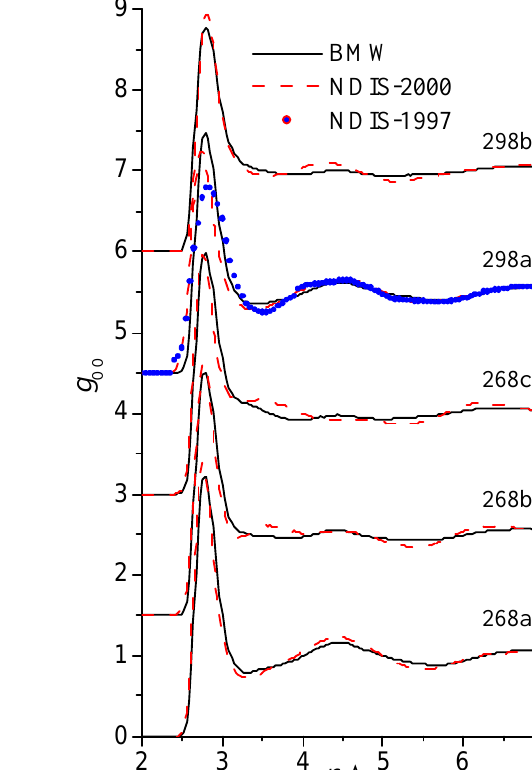
Figure 6. Radial distribution functions g